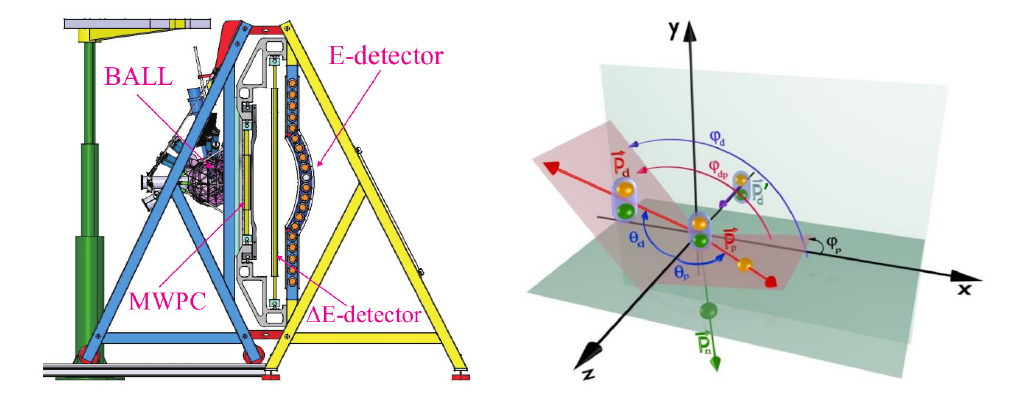
Figure 1: Left panel: A side view of the BINA experimental setup. Right panel: A schematic view of the breakup reaction with indicated polar ( θ and the relative azimuthal ( ∆ φ ratory reference frame. Figures adapted from [ 15 ]